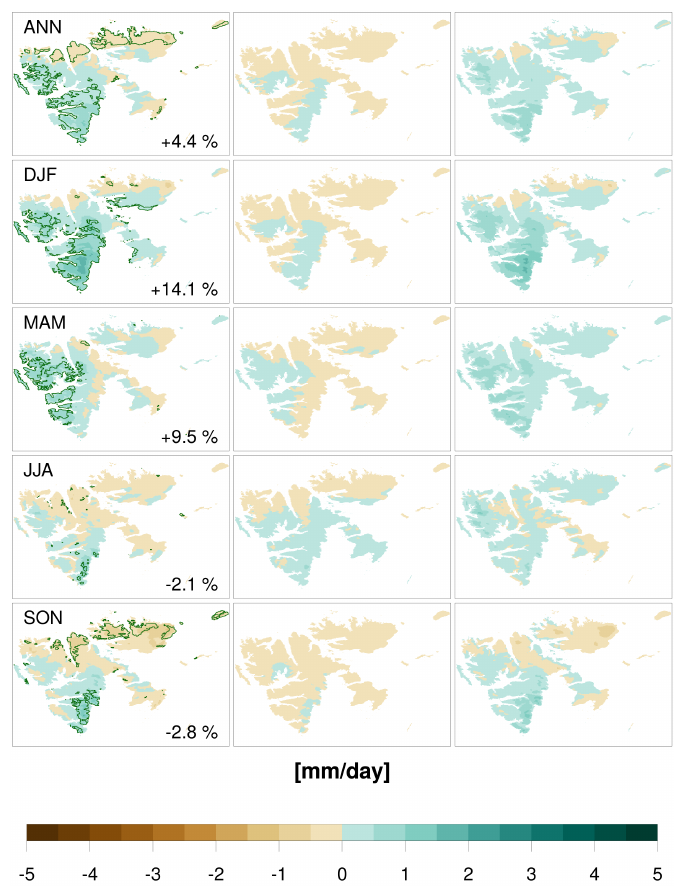
Figure 6. ( Left ): Difference between the annual and seasonal mean precipitation from the MPI-ESM-LR and the ERA-Interim driven COSMO-CLM simulation for the current climate (1971–2000 and 2004–2017, respectively). Statistically significant differences are outlined. ( Center ): The part resulting from differences between the weather type frequencies in MPI-ESM-LR and ERA-Interim. ( Right ): The part resulting from large-scale condition differences. The labels in the top left corners refer to the annual mean (ANN) or the months of the specific season of the